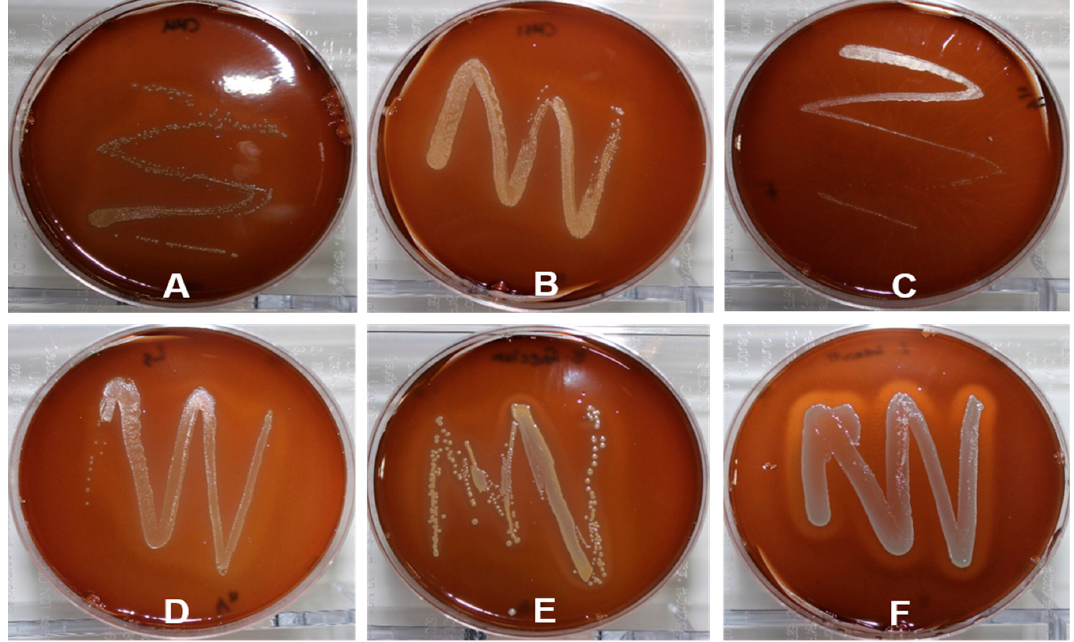
Figure 1. Hemolysis activity of W. cibaria strains and commercial probiotics including L. reuteri and L. salivarius . The plates inoculated with L. ivanovii KCTC 3444 as a positive control demonstrated β -hemolysis. ( A ) W. cibaria CMU; ( B ) W. cibaria CMS1; ( C ) L. reuteri ; ( D ) L. salivarius ; ( E ) E. faecium ; and ( F ) L. ivanovii.